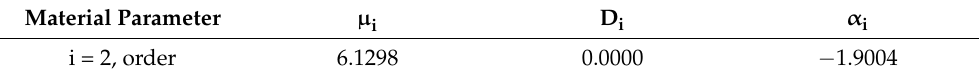
Figure 6. The test data for the second-order Ogden model vs. dog bone sample. Table 2. The parameters of the second-order Ogden model.